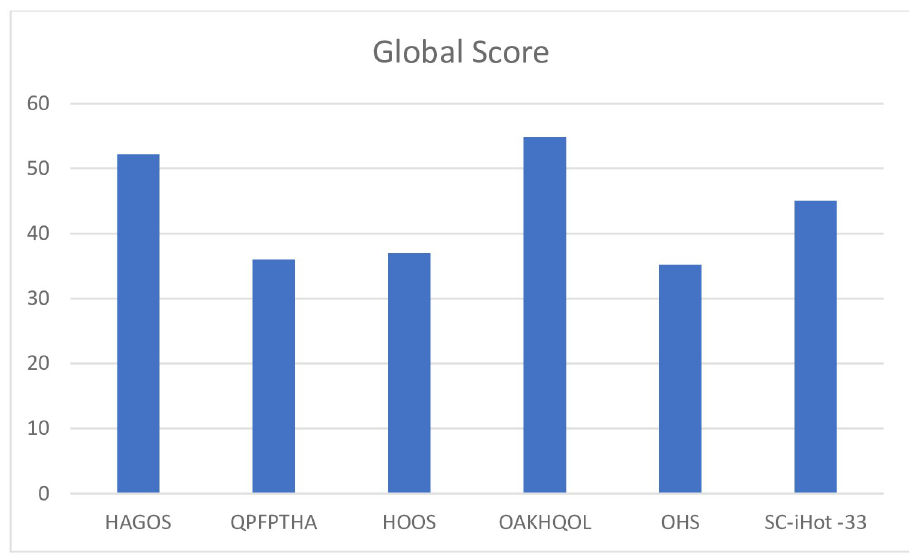
Fig 5. Validity attribute score for each PROM as evaluated by